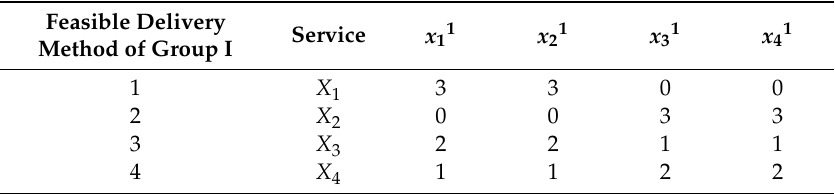
Table 9. The results of the feasible